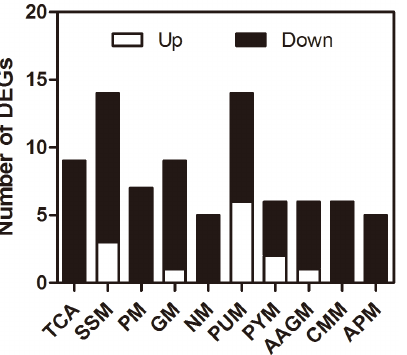
Figure 4. Modulation of basal metabolism-related genes in 24 hpi whiteflies. The numbers of up- and down-regulated genes are shown in white and black, respectively. The listed metabolism pathways are: TCA cycle (TCA, ko00020), Starch and sucrose metabolism (SSM, ko00500), Pyruvate metabolism (PM, ko00620), Galactose metabolism (GM, ko00052), Nitrogen metabolism (NM, ko00910), Purine metabolism (PUM, ko00230), Pyrimidine metabolism (PYM, ko00240), Alanine, aspartate and glutamate metabolism (AAGM, ko00250), Cysteine and methionine metabolism (CMM, ko00270), Arginine and proline metab- olism (APM,